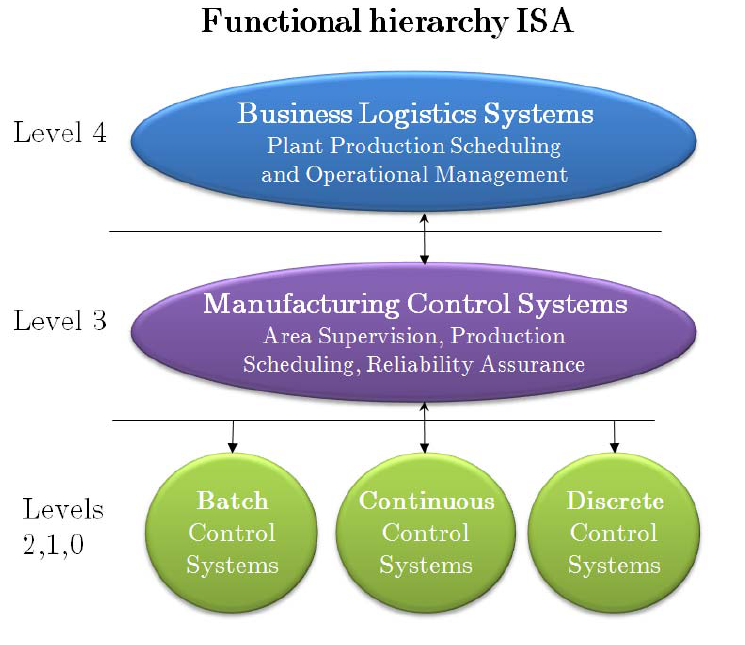
Figure 2. The Purdue Enterprise Reference Architecture